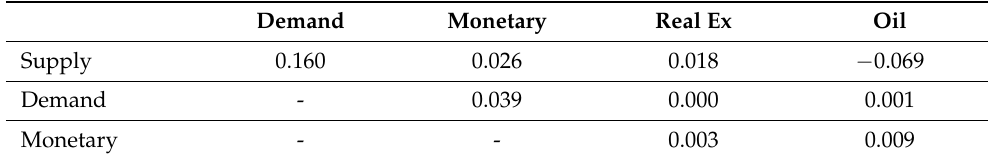
Table 1. Average pairwise correlations of